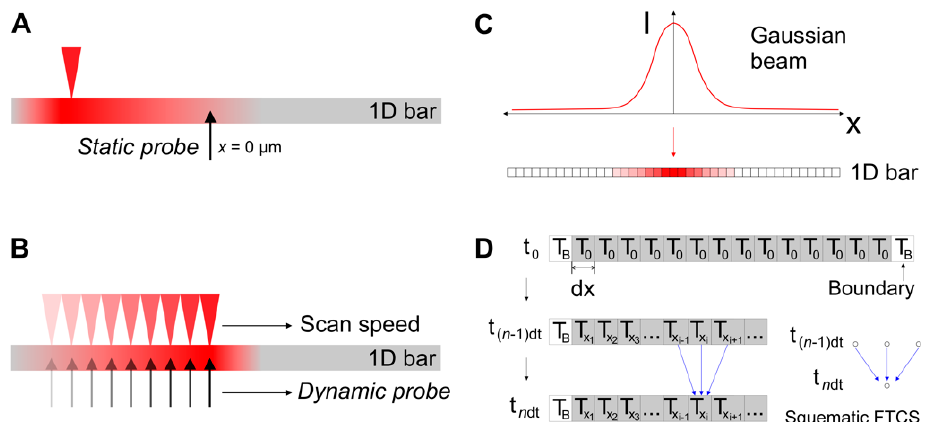
Figure 8. Schematic representation of the used model that implements the 1-D heat flow equation in a 1-D steel bar. Two general modes are employed, ( A ) a static probe that registers the temperature of individual pulses arriving at different positions from the probe used for simulation results of Figure 3A-B, and ( B ) a dynamic temperature probe and a scanning laser beam that heats the steel bar and moves from left to right at a given speed, such as in the experiments shown in Figure 3C. The moving temperature probe registers the temperature at intervals dt = 1 ns. ( C ) The temperature curve distribution used as input for each pulse correspond to a Gaussian beam, translated into the 1D bar individual cells which size is dx = 15 nm. ( D ) FTCS scheme for the temperature averaging of individual cell calculated every time increment dt = 1 ns.